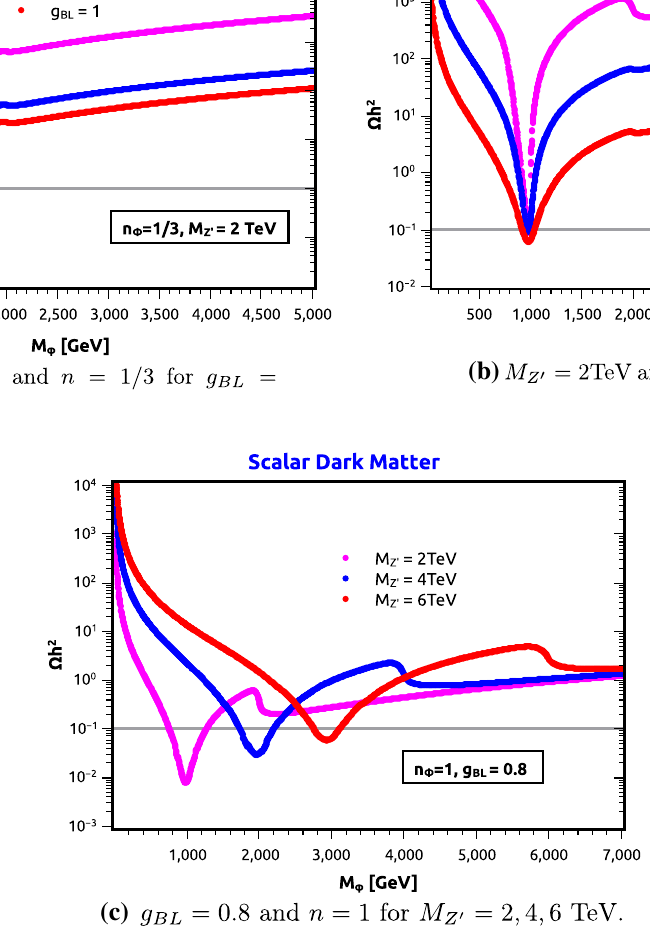
derivative and scale as g 4 hand a few remarks are in